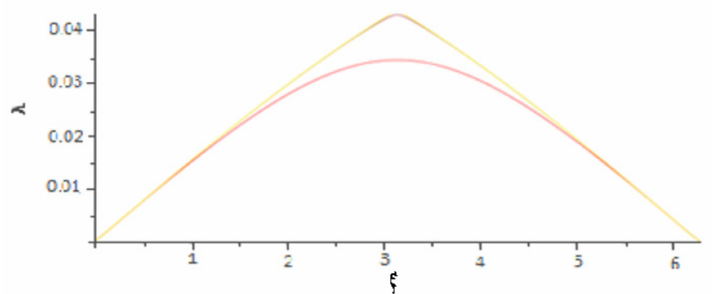
Figure 5. Small perturbations of a monodisperse crystal with a constant concentration of components of the form 0.25 + 0.25 + 0.25 + 0.25. N4: 0.25 + 0.24 + 0.25 + 0.26, color = brown; N5: 0.3 + 0.2 + 0.2 + 0.3,